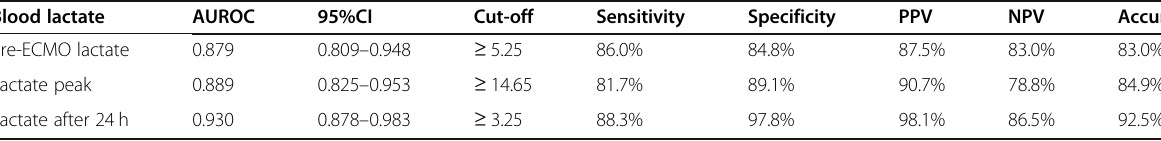
Table 3 The validity measures of blood lactate in differentiating mortality Blood lactate